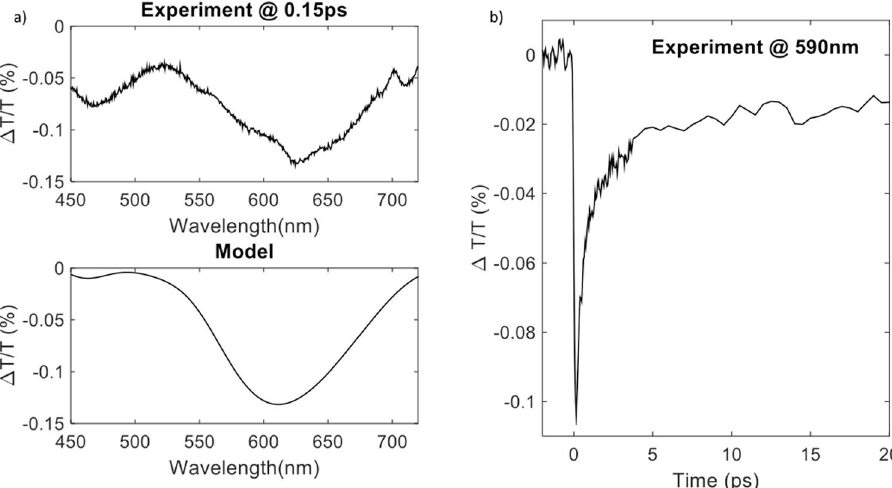
Figure 3. ( a ) Differential transmission spectrum at 0.15 ps pump-probe delay after ultrafast photoexcitation of the 1D photonic crystal at 260 nm (4.77 eV). Upper panel displays the model and lower panel displays the experiment. ( b ) Differential transmission dynamics at 590